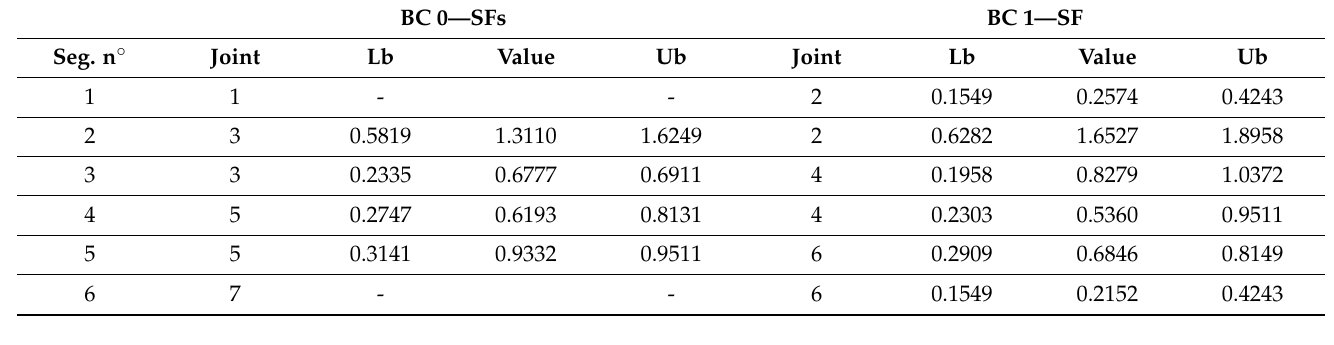
Table 5. BCPs user-defined bounds & SF evaluated upper and lower bounds.